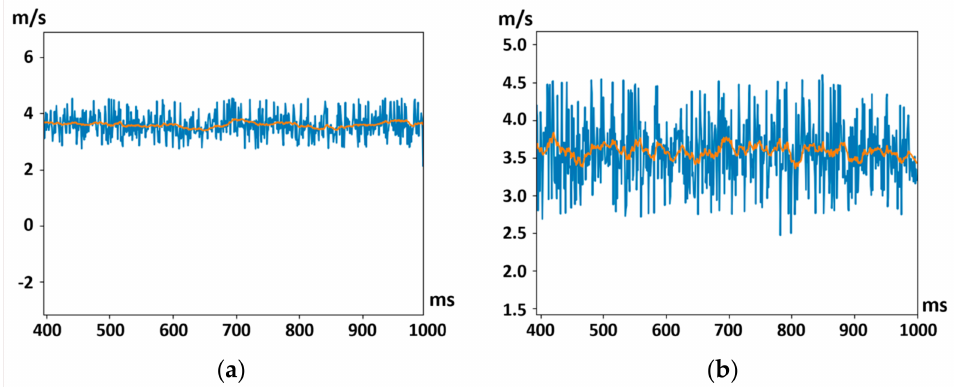
Figure 5. ( a ) Output with random noise of magnitude ± 1. ( b ) Output with random noise of magnitude ± 2.